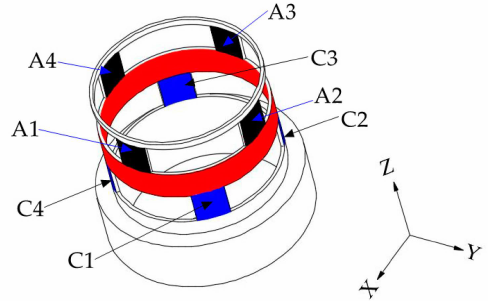
Figure 6. Basic structure of the cylinder-shaped elastic structural